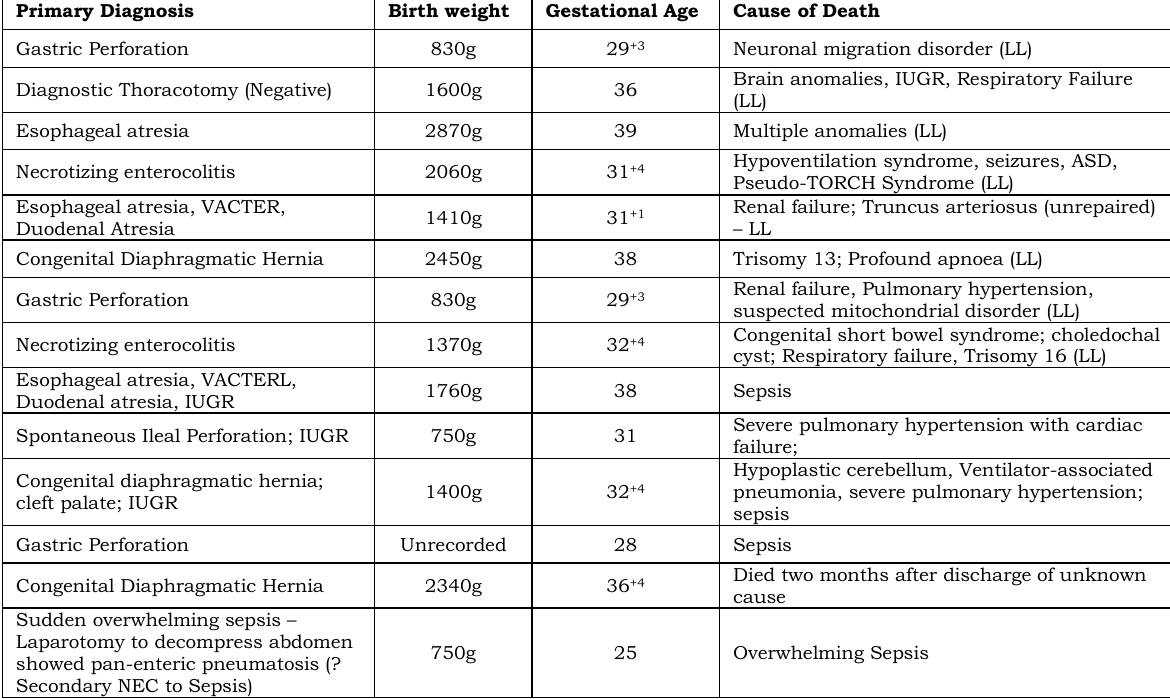
Table 3: Mortality, primary diagnosis, demographics, and causes of death (LL